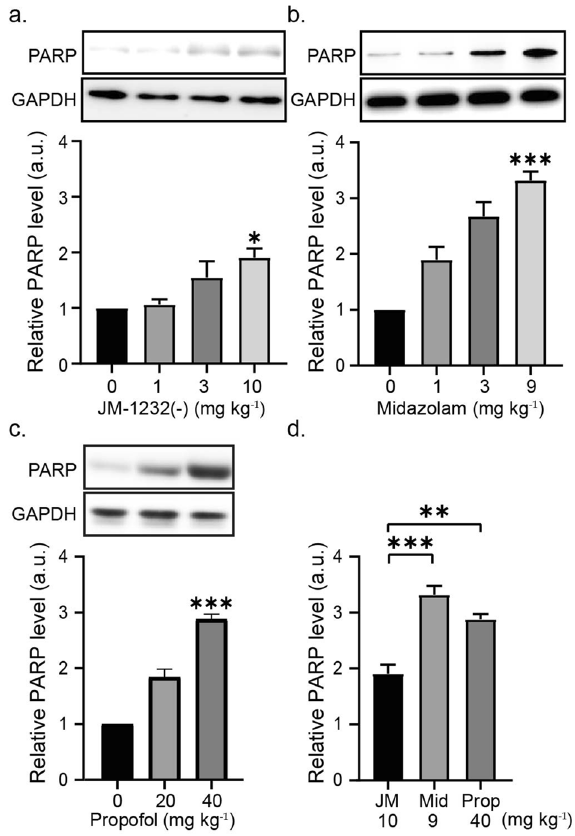
Figure 2. JM-1232(−) induces a small increase in apoptosis in the developing mouse forebrain, but this increase is less than that induced by other anaesthetics. Comparison and quantitation of amount of apoptosis resulting from different doses of JM-1232(−) with comparable doses of midazolam and propofol. Western blot analysis demonstrated that expression levels of cleaved PARP increased in a dose-dependent manner 6 h post-anaesthetic injection in P6 mouse pups. ( a - c ) Protein extracts of the forebrain were analysed for cleaved PARP immunoreactivity. GAPDH was used as a loading control. In order to evaluate apoptosis levels, the PARP protein band intensities were normalised to those of the loading control. ( a ) JM-1232(−) (0 mg kg −1 [n = 5]; 1 mg kg −1 [n = 4]; 3 mg kg −1 [n = 4]; 10 mg kg −1 [n = 5]). ( b ) midazolam (0 mg kg −1 [n = 5]; 1 mg kg −1 [n = 5]; 3 mg kg −1 [n = 5]; 9 mg kg −1 [n = 7]). ( c ) Propofol (0 mg kg −1 [n = 5]; 20 mg kg −1 [n = 5]; 40 mg kg −1 [n = 5]). (d) JM-1232(−) induced lower levels of apoptosis when compared with those by propofol or midazolam. Apoptosis levels at the dose of equivalent sedative effect were normalised to apoptosis levels in the corresponding vehicle controls. Comparisons of the means among groups were performed using Kruskal-Wallis test followed by Dunn post hoc test (a) and one-way ANOVA followed by Tukey post hoc test (* p < 0.05, ** p < 0.01, *** p < 0.001). Error bars are SEM. Full-length blots are presented in Supplementary Fig.